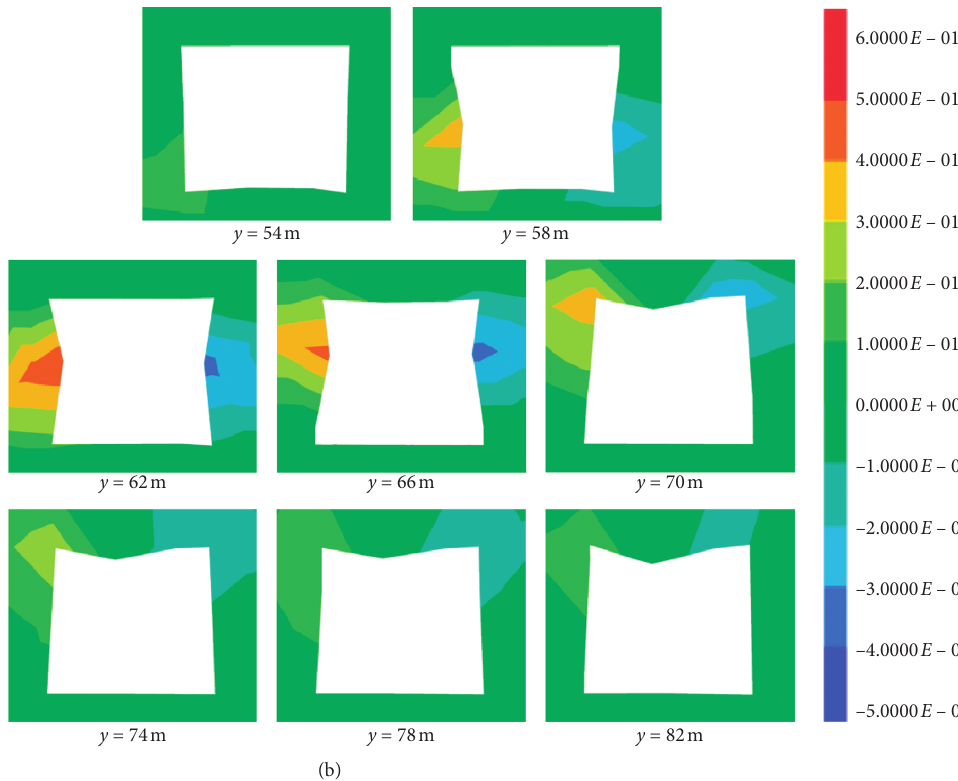
Figure 13: x -displacement of the cross-cut walls in PTR section. (a) Maximum x -displacement of the cross-cut walls after backfilling in measure point y � 70m. (b) x -displacement of the cross-cut walls without